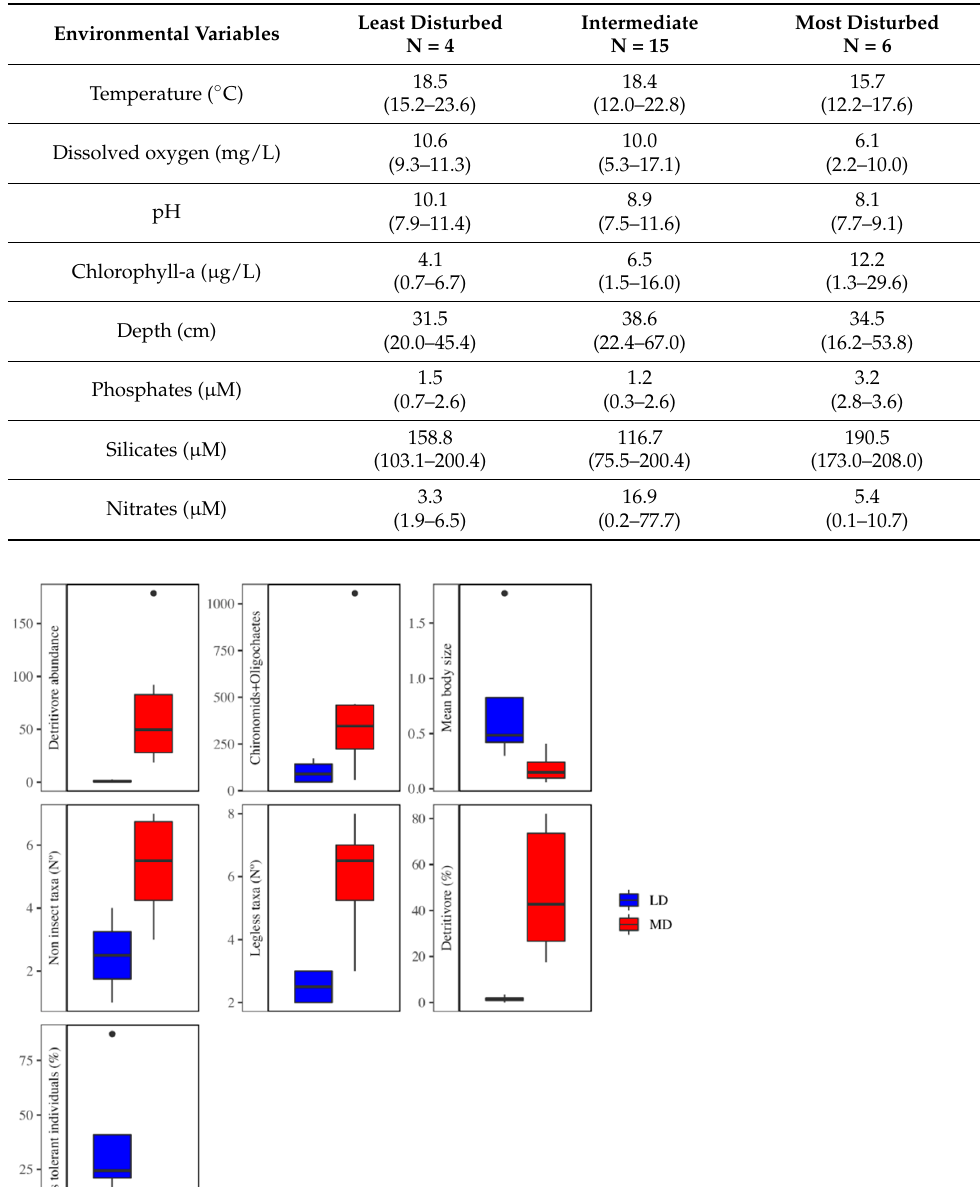
Table 1. Mean values and range (in parenthesis) of the environmental variables in the least disturbed, intermediate disturbed and most disturbed sites, classified according to the IDI index. In the case of pH, the values represent the median. N = number of sites within each IDI category.